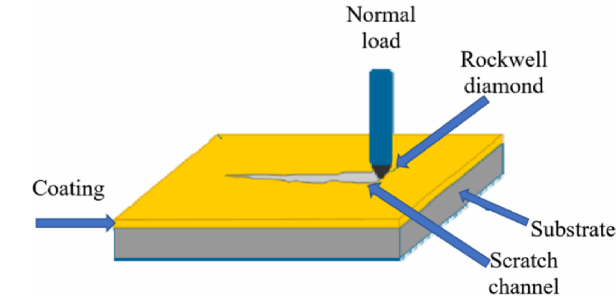
Figure 2: A schematic illustrating w scratch test on a coated